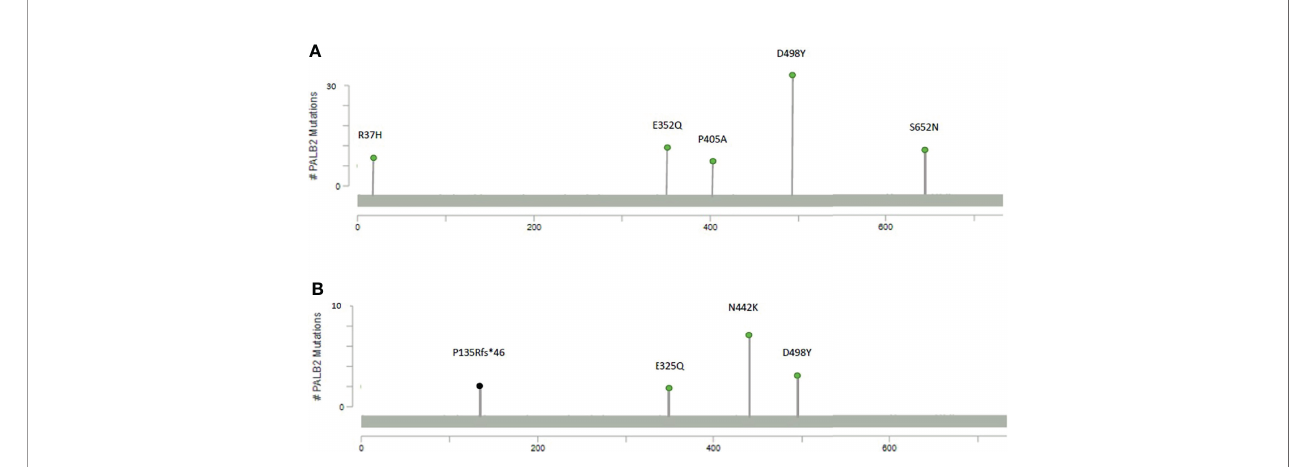
FIGURE 1 | Mutational maps of the PALB2 with the most frequent mutations, including (A) germline mutations and (B)